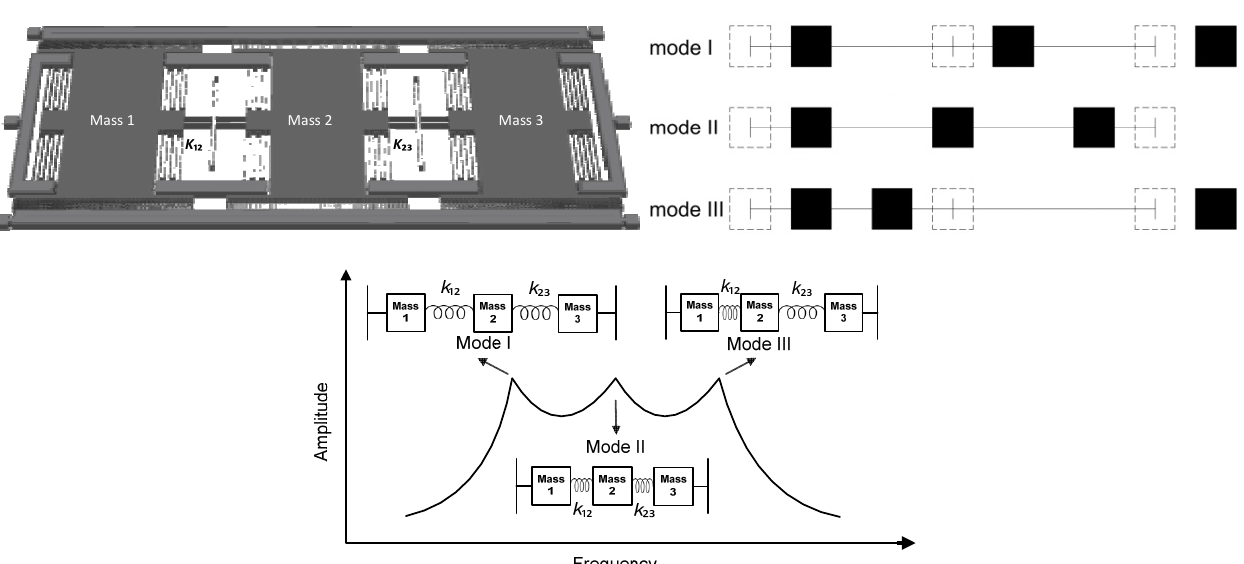
Figure 4: Example of design strategy for amplifying the bandwidth of a capacitive generator through the coupling of modal